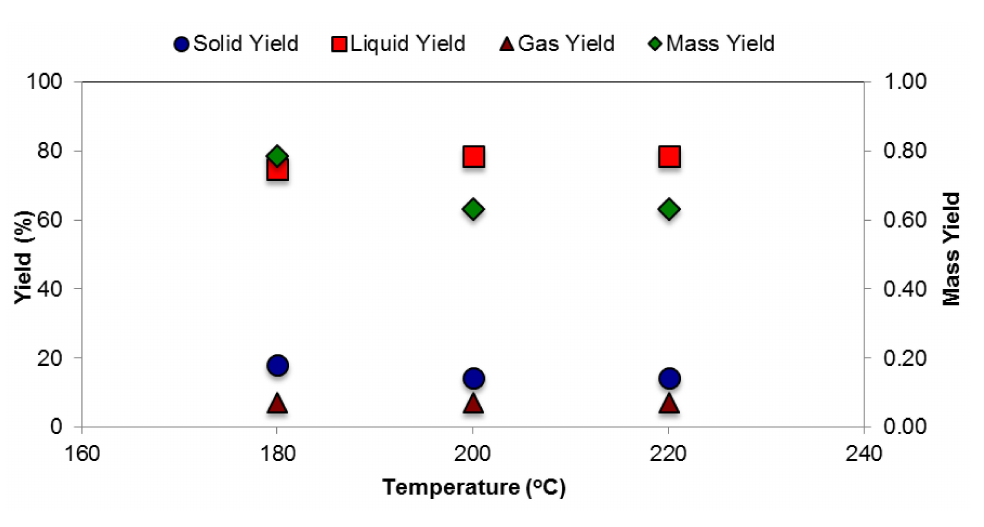
Figure 1. Effect of temperature on the products distribution.